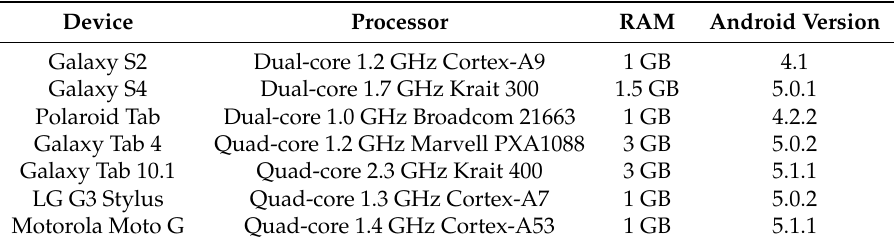
Table 3. Devices utilized for testing and evaluating the proposed